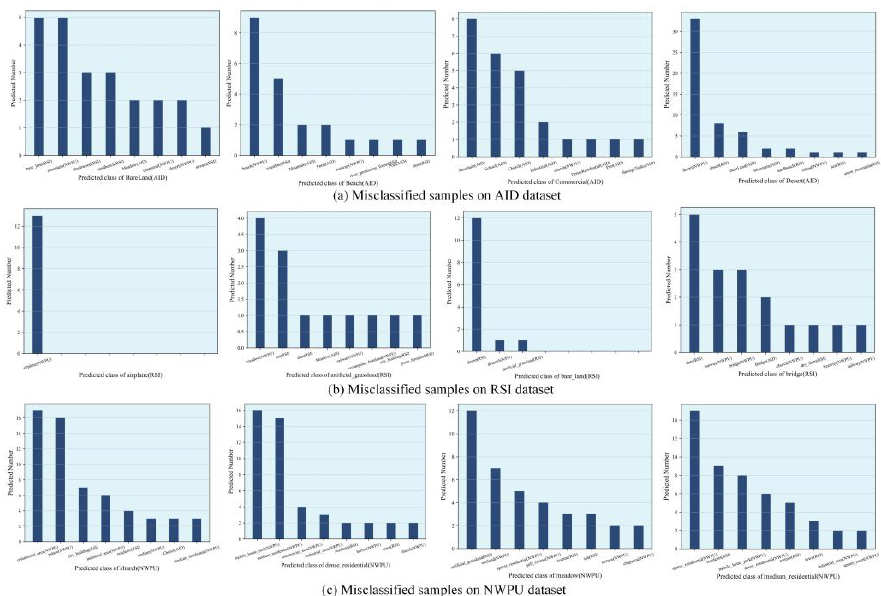
Figure 12. Histograms of misclassified samples among the three datasets. ( a ) indicates the statistic results of misclassified scenes on the AID dataset; ( b ) indicates the statistic results of misclassified scenes on the RSI dataset; ( c ) indicates the statistical results of misclassified scenes on the NWPU dataset.